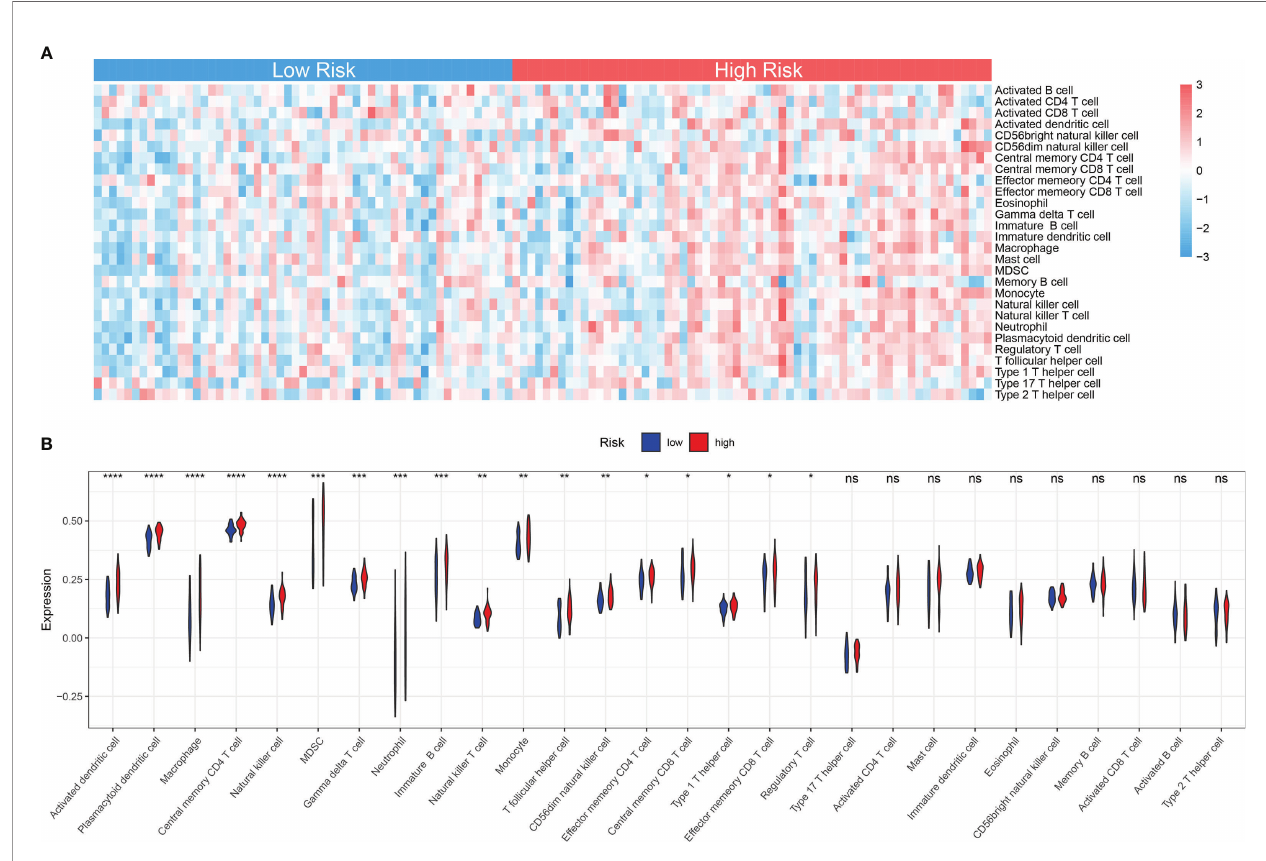
FIGURE 7 | Immune landscape between low and high MRG risk groups of AML patients. (A) Heatmap of immune in fi ltration of 28 immune cell types between two MRG risk groups in TCGA-AML cohort. (B) Box plots showing signi fi cant differences of immune cells between two MRG risk groups. MRG, mitochondria-related gene; AML, acute myeloid leukemia. *p < 0.05, **p < 0.01, ***p < 0.001 and ns, not signi fi cant, high risk group versus low risk